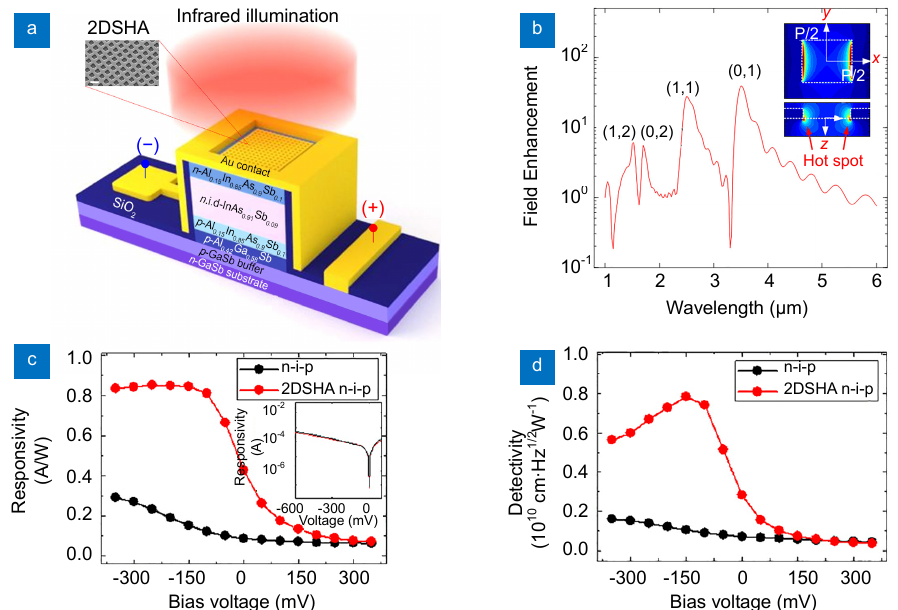
Fig. 4 | Plasmonic 2DSHA-hetero n-i-p photodetector . ( a ) Schematic diagram of the device. ( b ) Spectra of electric field enhancement in 2DSHA with a period of 900 nm at the hot spot position, as indicated in the inset. ( c ) Room-temperature responsivity. ( d ) Room-temperature blackbody detectivity. Figures reproduced from: ref. 30 , AIP